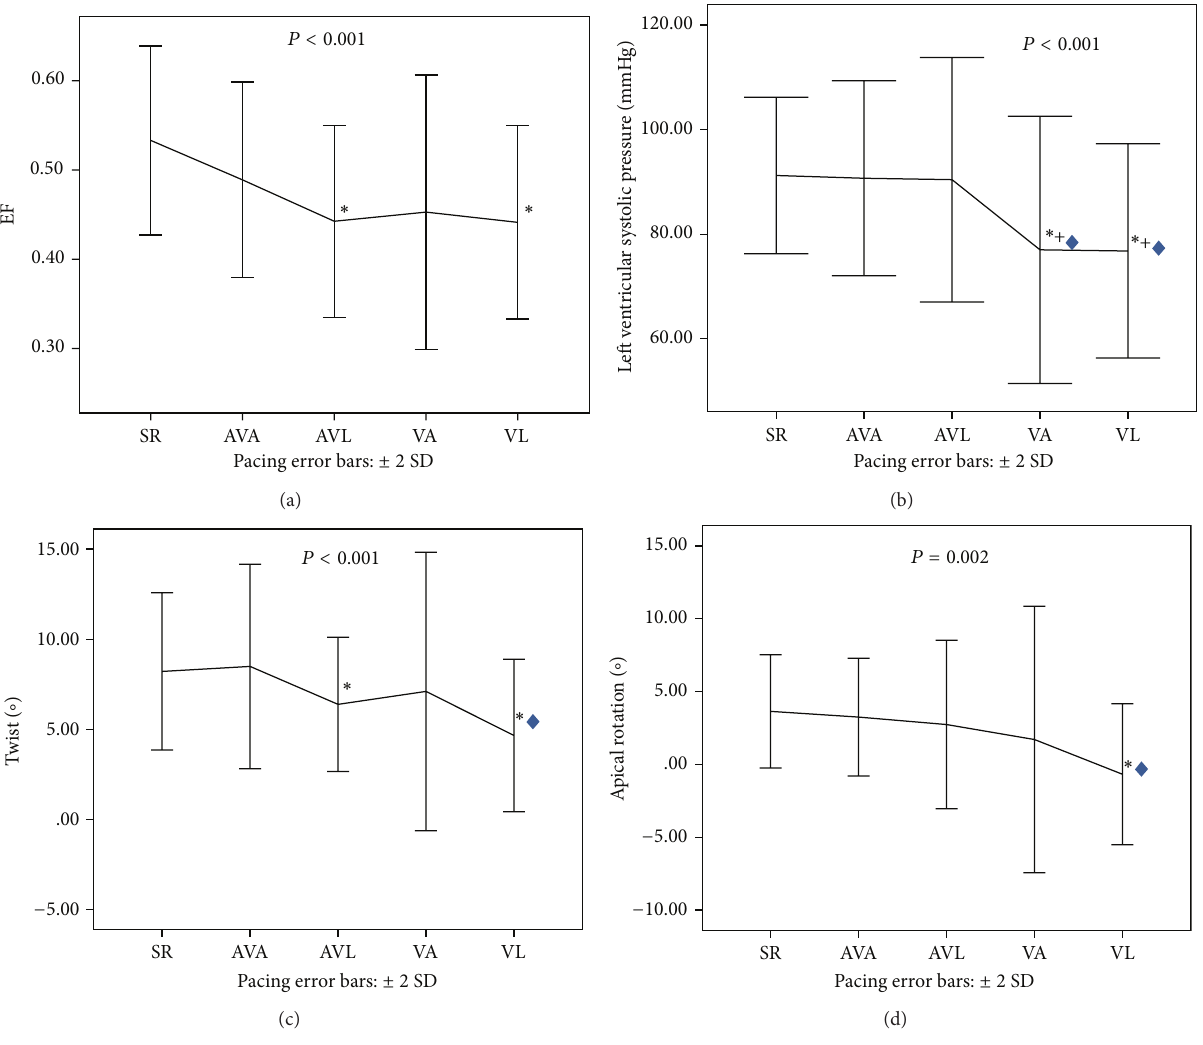
Figure 3: Diagrammatic pattern of echocardiographic ejection fraction (a), left ventricular (LV) systolic pressure measurement (b), twist (c), and apical rotation (d) obtained by speckle tracking imaging during sinus rhythm (SR), atrioventricular LV pacing at the apex (AVA) and lateral wall (AVL), and ventricular pacing at the apex (VA) and lateral wall (VL). Asterisk ( ∗ ) denotes that the mean difference from SR is significant at the 0.05 level; rhombus ( ◊ ) denotes significant differences from AVA and plus sign (+) from